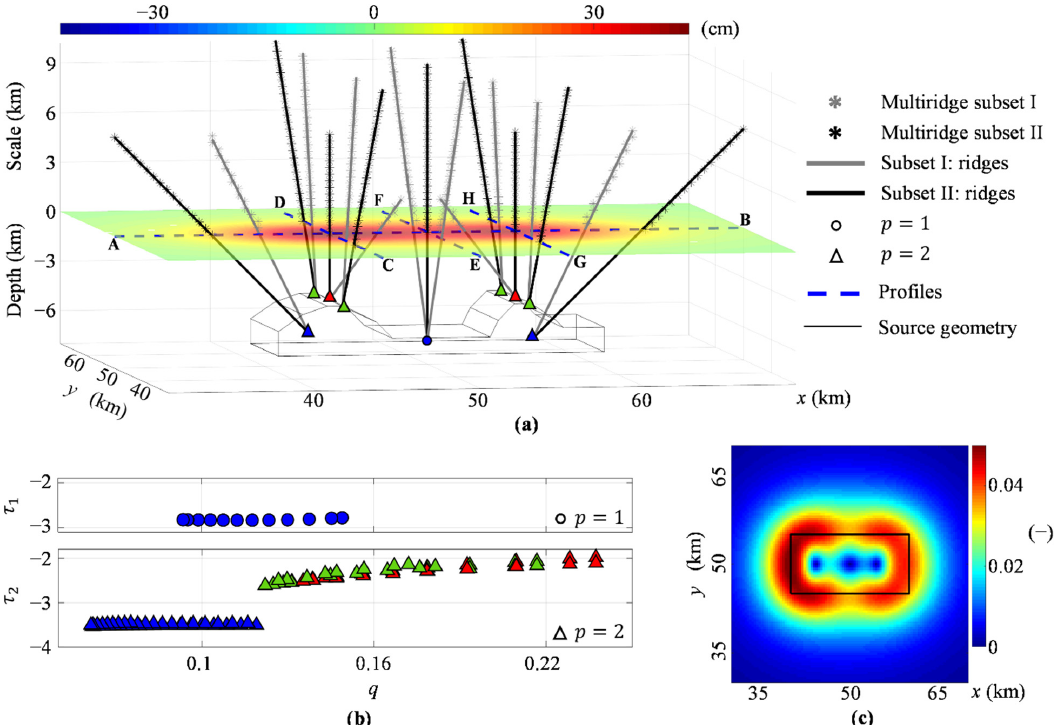
Figure 3. Single source case. ( a ) Multiridge method applied to the vertical derivatives of orders 1, 2 of the simulated vertical deformation (horizontal slice). The results are displayed along with the AB ( p = 2), CD ( p = 2), EF ( p = 1), and GH ( p = 2) profiles with different symbols (see legend). ( b ) ScalFun method applied to the ridge subset II ( f p ) for both p = 1 ( up ) and p = 2 ( down ) cases; colored symbols indicate τ p = ∂ log ( f p )/ ∂ log ( z ) as a function of q = 1/ z using the source depth estimated by the Multiridge method; z is the vertical scale. ( c ) THD w calculated on the simulated vertical deformation in ( a ); the black lines indicate the source boundary. The map is generated by using Matlab R2018b software (https://it.mathworks.com/products/matlab (accessed on 1 November 2021)).